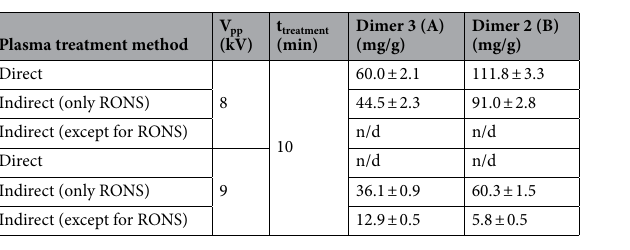
Table 1. Contents of dimers A and B generated by plasma treatment method a . a Mean ± SD (n = 3), n/d: not